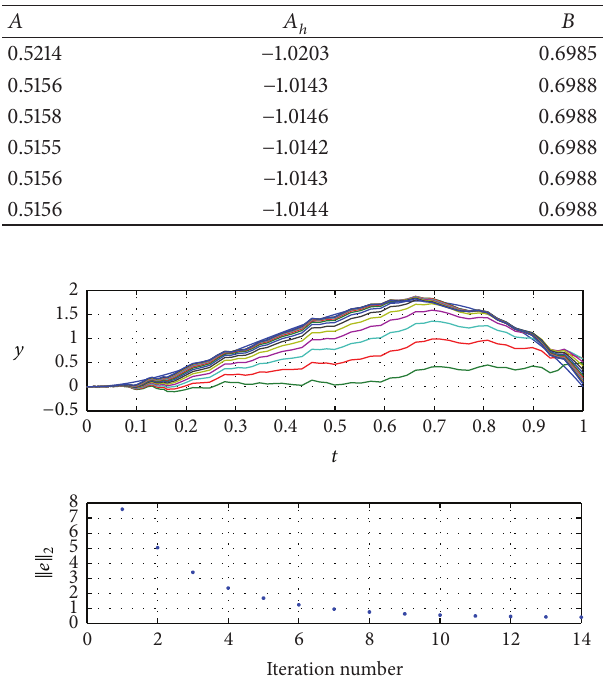
Figure 6: The optimal simulation results of the ILC scheme from (46), (2), and